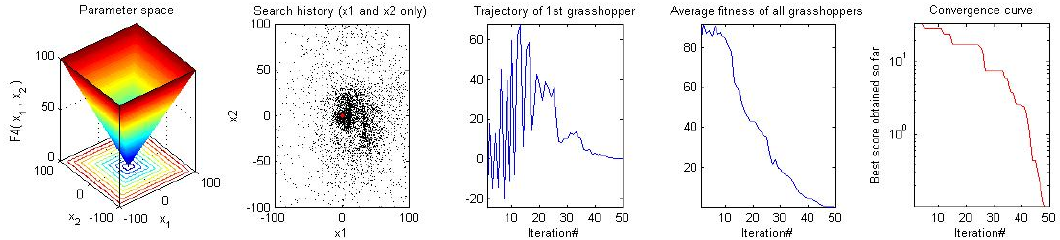
Figure 5. HAGOA search behavior on unimodal function